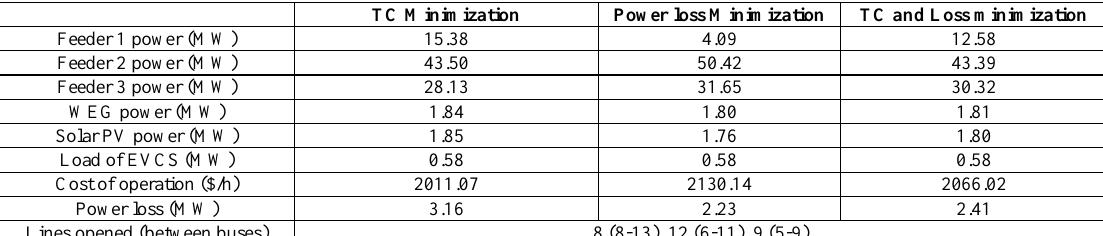
Table 2. Optimum power outputs for single and multiple objectives of 17 bus unbalanced